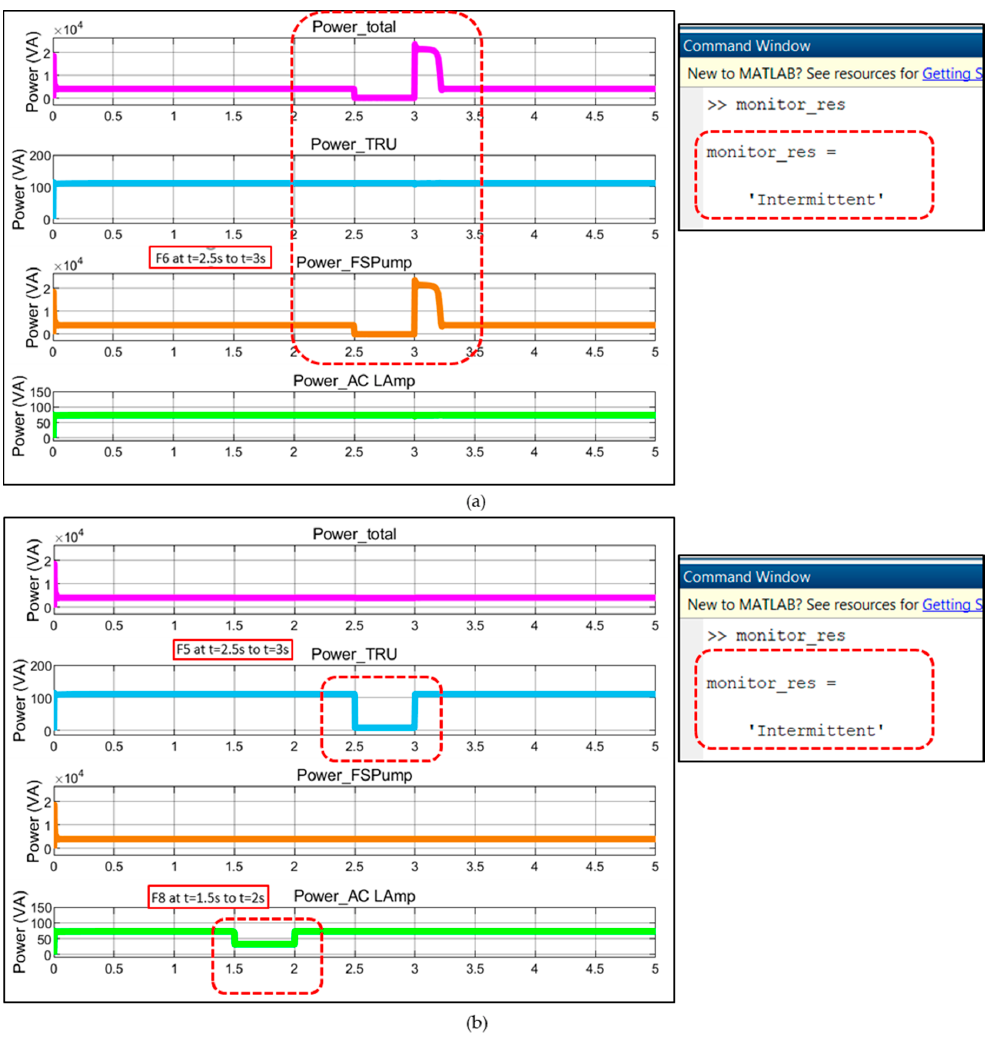
Figure 15. ( a ) Diagnostics for one intermittent fault (F6). ( b ) Diagnostics of multiple intermittent